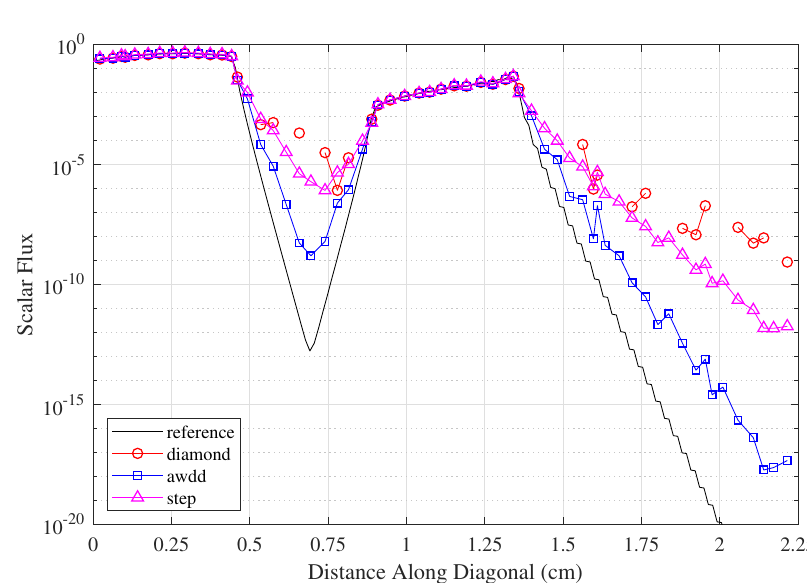
Figure 5: Scalar flux solution for different SBA closures along the domain diagonal of a 1,024 cell (pre-split) polygonal mesh. The reference solution was generated with SBA-DD on a 320x160 Cartesian